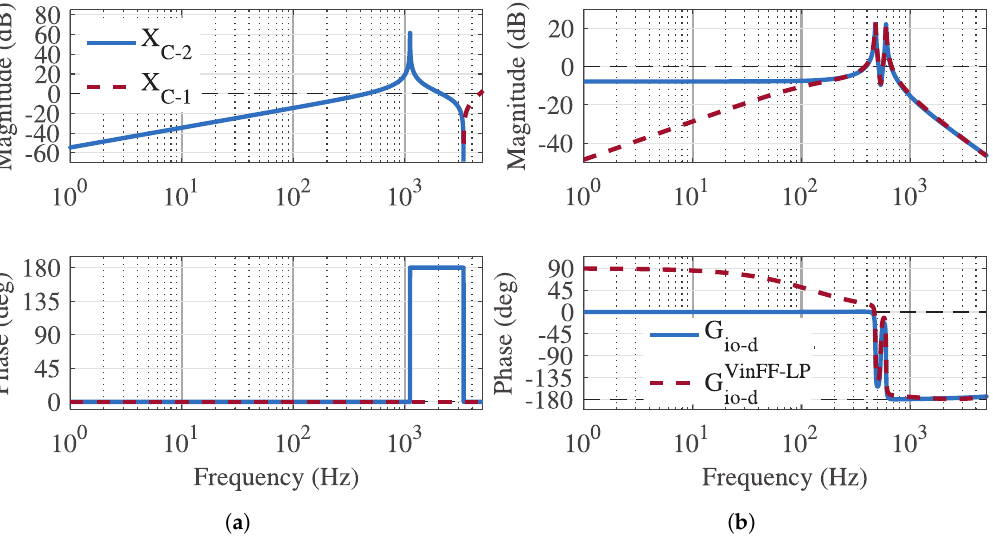
Figure 6. ( a ) Solutions X C − 1 and X C − 2 for the low-pass filter related to the input-to-output dynamics. ( b ) Input-voltage feedforward-affected input-to-output dynamics d component with and without the low-pass filter.